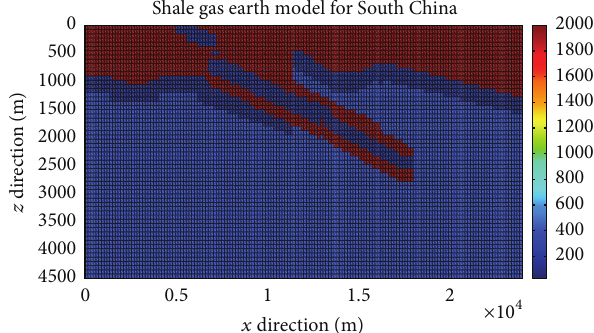
Figure 12: 2D earth model for South China shale